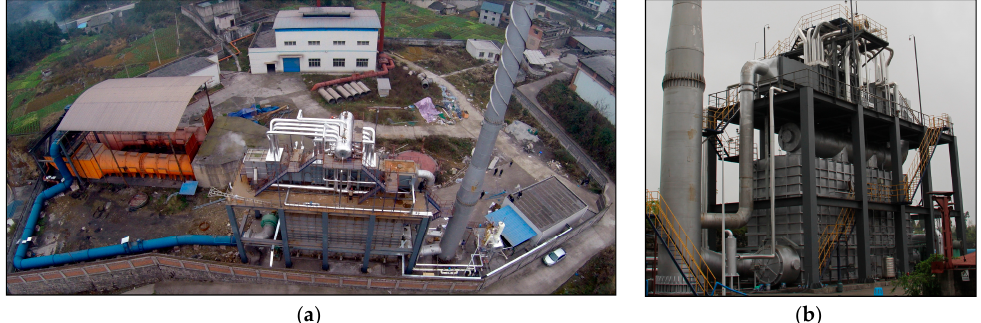
Figure 2. On-site, industrial-scale VAM oxidation system: ( a ) Photograph of the system; ( b ) TFRR ( lower ) and boiler ( upper ).